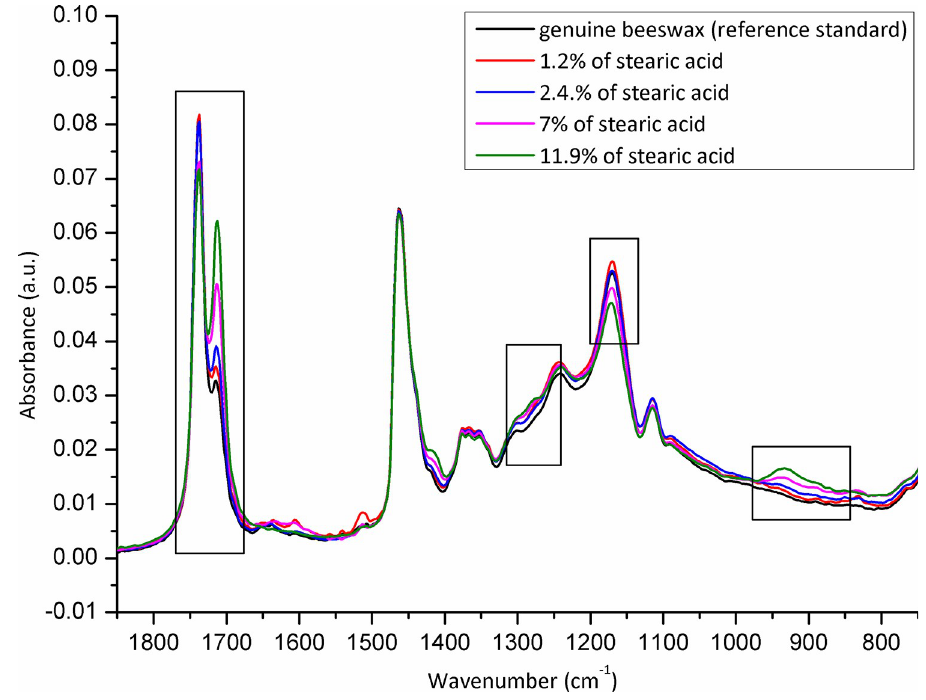
Fig 14. Adulterated beeswax samples versus genuine beeswax (reference standard) with an emphasis on spectral regions indicative for adulteration detection: Stearic acid—adulterated beeswax samples. Due to some spectra overlaps (close share of spectra to 2%), only spectra with more than 2% of difference were presented in this figure. Wavenumber, the number of waves per unit distance; cm, centimetre; a.u. is for the absorbance unit.